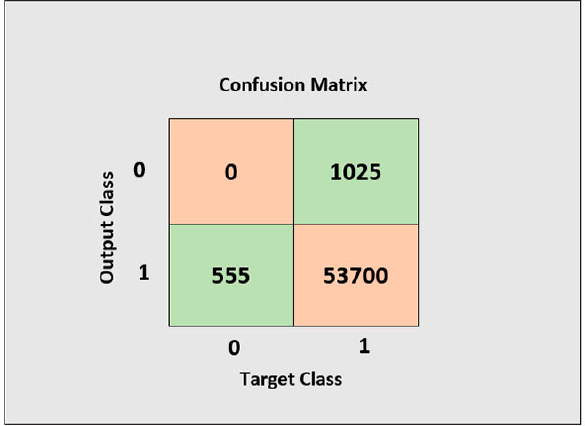
Figure 9. Confusion matrix of the ECG2 classified beats.